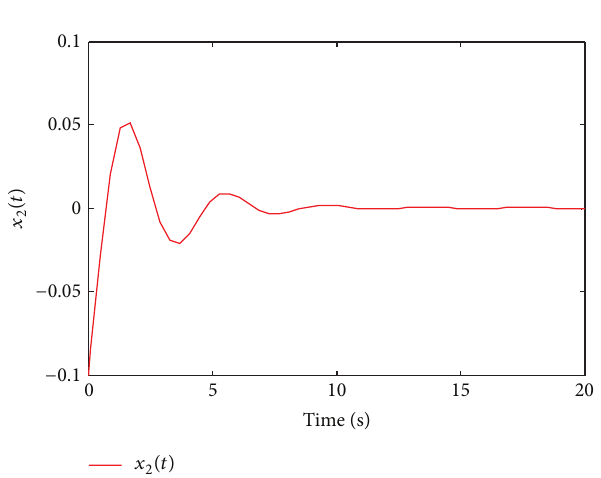
Figure 5: Simulation result of the angular velocity.